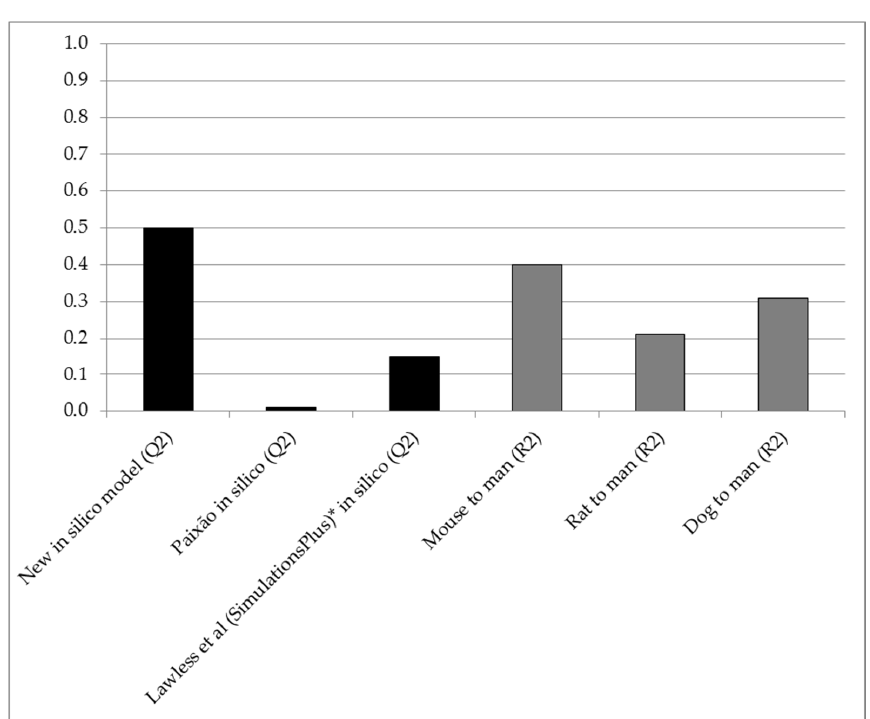
Figure 2. Q 2 (predictive accuracy; Y-axis) obtained with the new in silico model ( n = 156), compared to interspecies R 2 for compounds of the same dataset ( n = 28, 101 and 106 for mice, rats and dogs, respectively) and Q 2 achieved by other in silico method developers ( n = 68 and 62 in studies by Paixão and Lawless et al., respectively) [3,4]. * Using a set of compounds with known high permeability, solubility and gastrointestinal absorption [4].